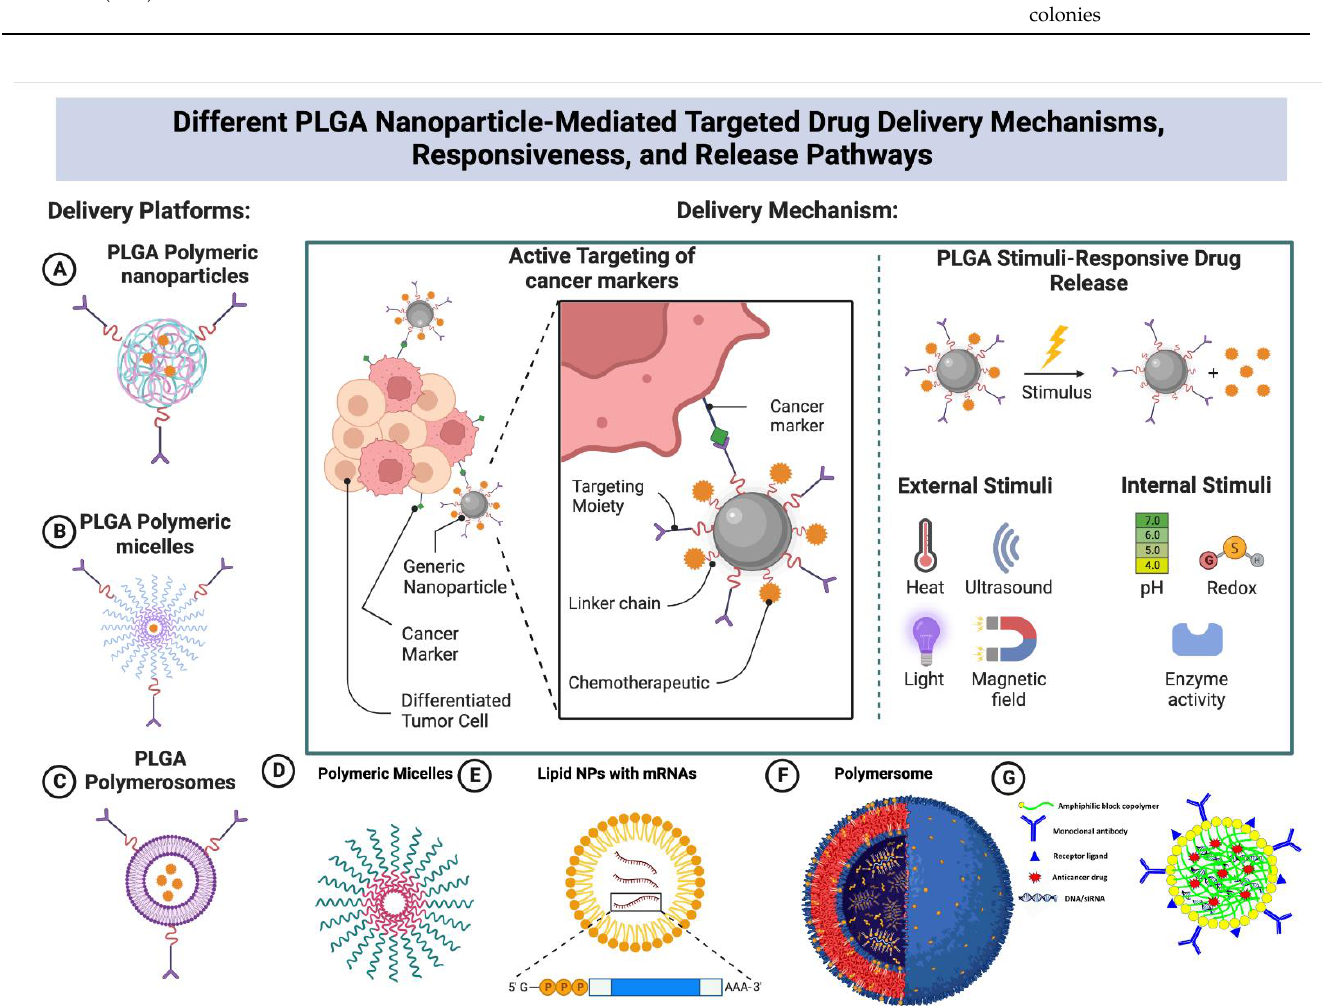
Figure 5. The images depict different PLGA polymer-based carriers that have been fabricated over recent years with the most important types used especially for targeting cancer (Figures ( A - F )). Also, Figure ( G ) shows how PLGA amphiphilic block copolymers looks when loading with different anticancer drugs and/or DNA or RNA and decorated with small molecules receptor ligands or mono- clonal antibodies for active targeting. The active targeting of cancer utilizing PLGA functionalization with different cancer markers makes them one of the most promising platforms for both treatment and diagnostics. The PLGA stimuli responsive release could be external or internal stimuli. The figure was created with BioRender.com. Table 2. Some examples of preclinical studies of PLGA-based nanomaterial therapy that has been used as anticancer delivery systems.